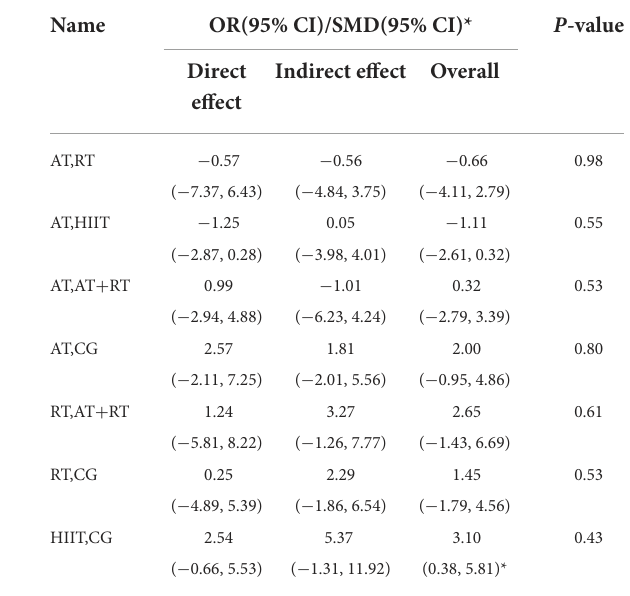
TABLE 4 The consistency of nodal analysis direct and indirect